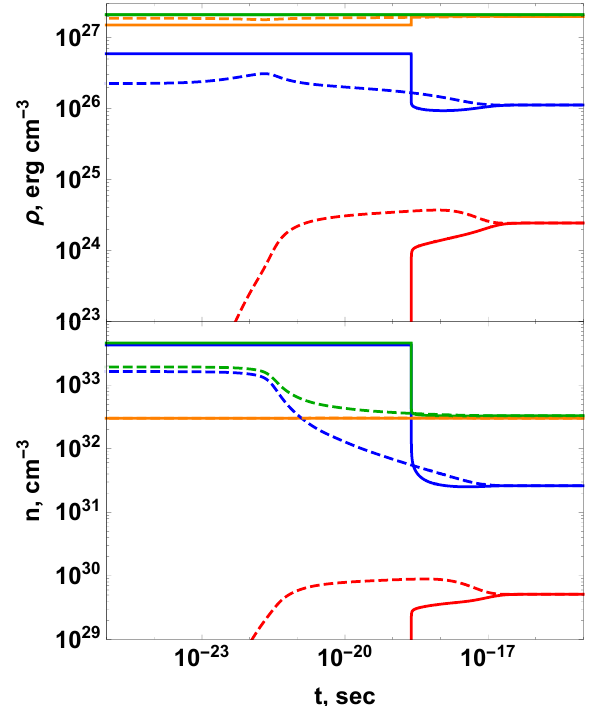
Figure 6. Time evolution of energy density (top) and particle number density (bottom) for relativistic photon-electron plasma with degenerate initial pair state (solid) and nondegenerate initial electron state (dashed). Blue: photons, orange: electrons, red: positrons and green: total. Final equilibrium temperature is θ fin =